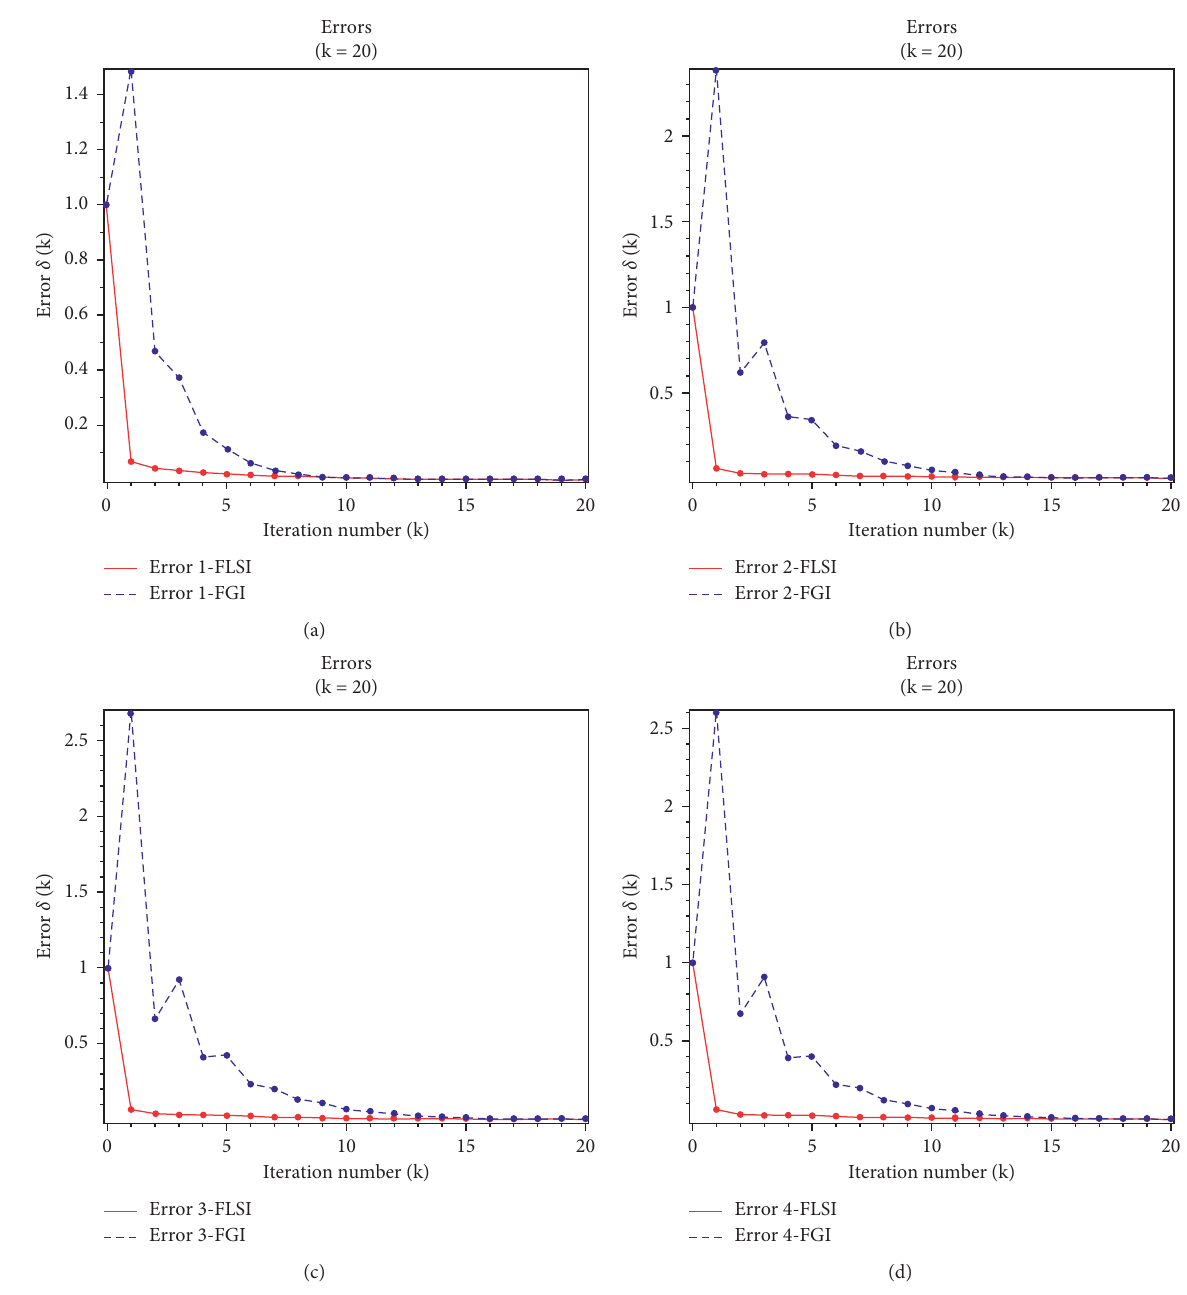
Figure 2: Comparison between δ l ( k ) of FGI and FLSI for the first 20 iterations for Example